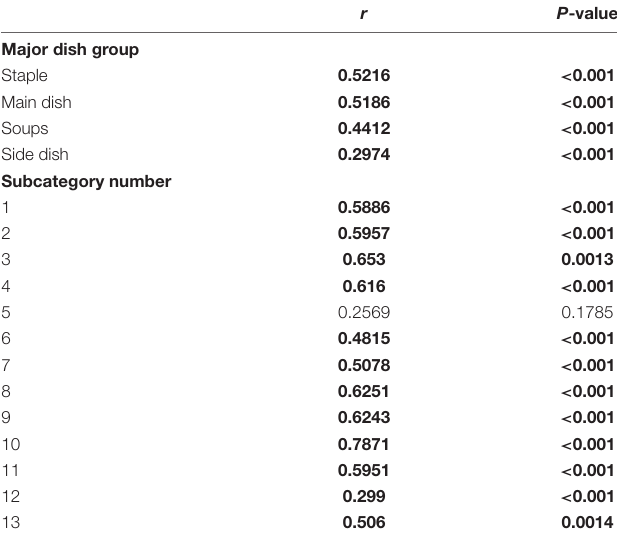
FIGURE 4 | The correlation between the nutrient-rich food index (NRF) 6.3 score and the Ajinomoto Group Nutrient Profiling System (ANPS) score among 1,089 dishes. TABLE 5 | Pearson’s correlation coefficients among the Ajinomoto Group Nutrient Profiling System (ANPS) and nutrient-rich food index (NRF) 6.3 scores in major dish group and dish subcategories of the total 1,089 dishes